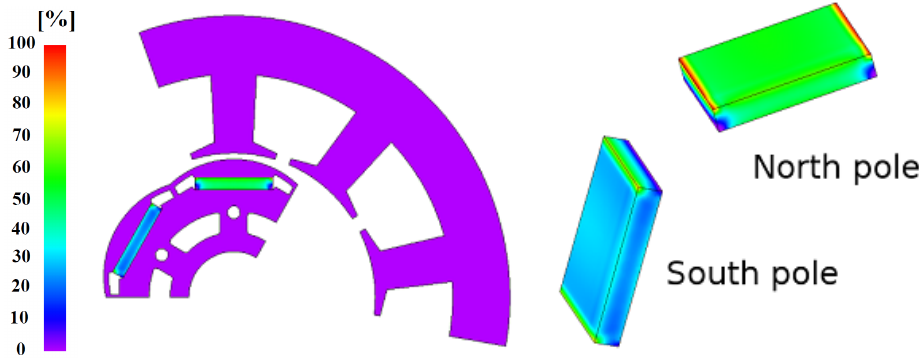
Figure 11. FE-predicted magnet remanence ratio in the experimental IPM after locked-rotor test us- ing the estimated thermal coefficients (20 A at 100 degC).